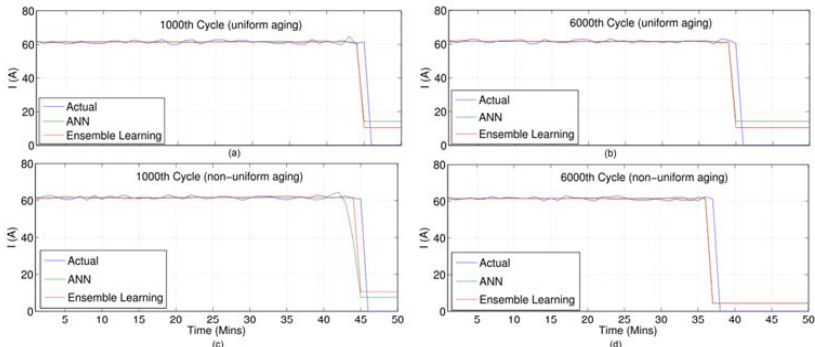
Figure 14. Charging profiles predictions for uniform and non ‐ uniform aging of cells. ( a ) 1000th Cycle (uniform aging); ( b ) 6000th Cycle (uniform aging); ( c ) 1000th Cycle (non ‐ uniform aging); ( d ) 6000th Cycle (non ‐ uniform aging).